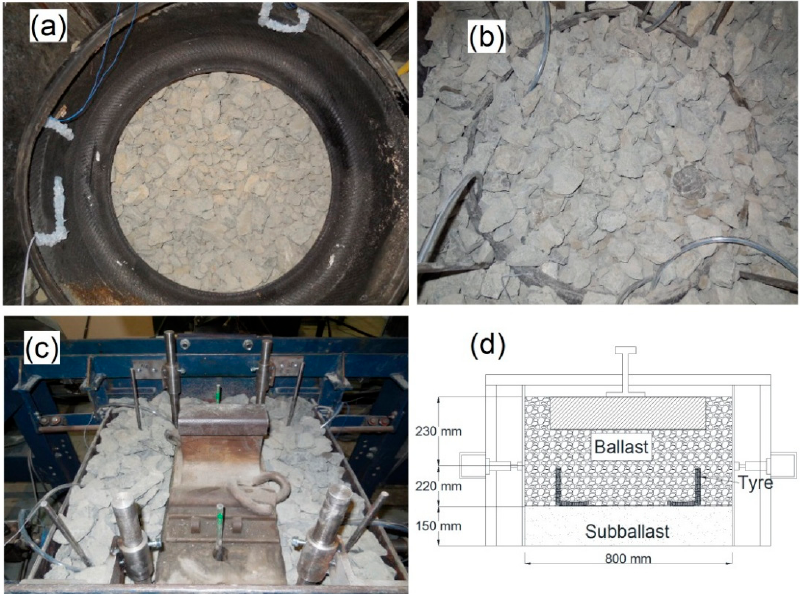
Figure 10. ( a ) Tire before experiment; ( b ) tire filled with ballast; ( c ) testing set up; ( d ) schematic illustration (adopted from Indraratna et al. [4]—with permission from